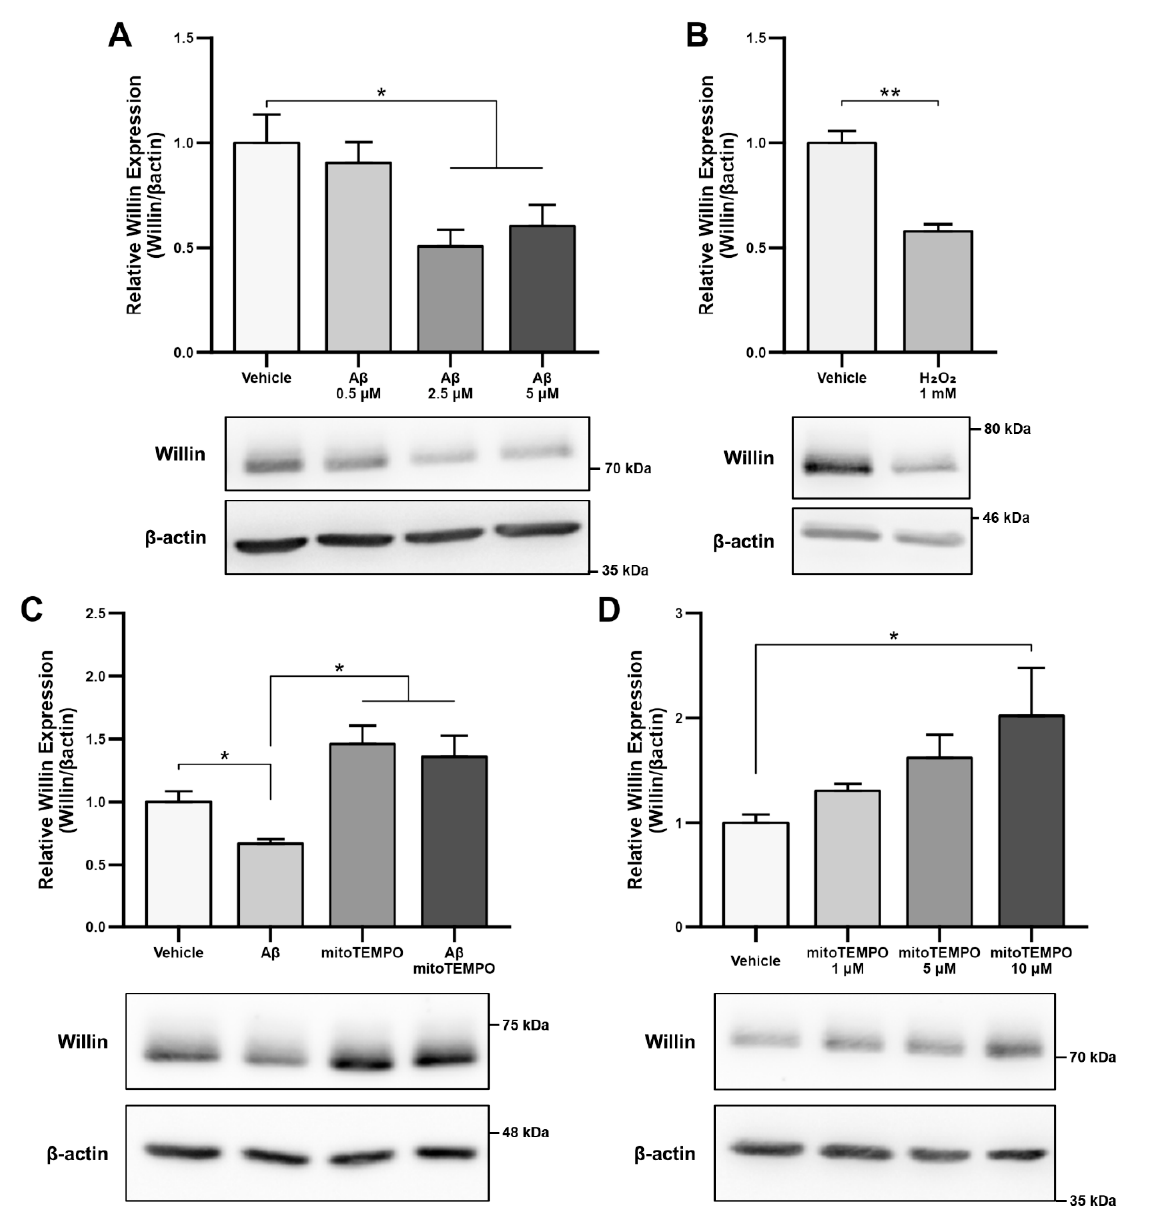
Figure 1. A β and oxidative stress downregulate Willin/FRMD6 expression in hippocampal HT-22 cells. Willin/FRMD6 protein levels in mouse hippocampal HT-22 cells after the following treatments: ( A ) A β at the indicated concentrations for 24 h, n = 4–6 per group; ( B ) H 2 O 2 at 1 mM for 24 h, n = 3 per group; ( C ) MitoTEMPO, a MnSOD mimetic, pretreatment (10 µ M) for 1 h prior to addition of A β (2.5 μ M) for 24 h, n = 3 per group; ( D ) mitoTEMPO at the indicated concentrations for 24 h, n = 3 per group. β -actin served as a protein loading control. Upper panels represent quantification of immunoreactive bands relative to β -actin. Data are expressed as fold change relative to the vehicle control group. Representative immunoblots are shown underneath. * p < 0.05. ** p <0.01.